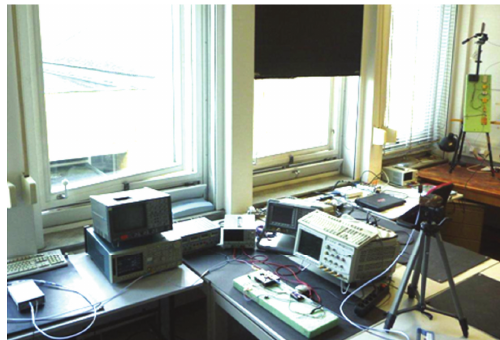
Figure 12: Measurement scenario in a laboratory room. An MU antenna placed on the tripod and the AP antenna in the background (top